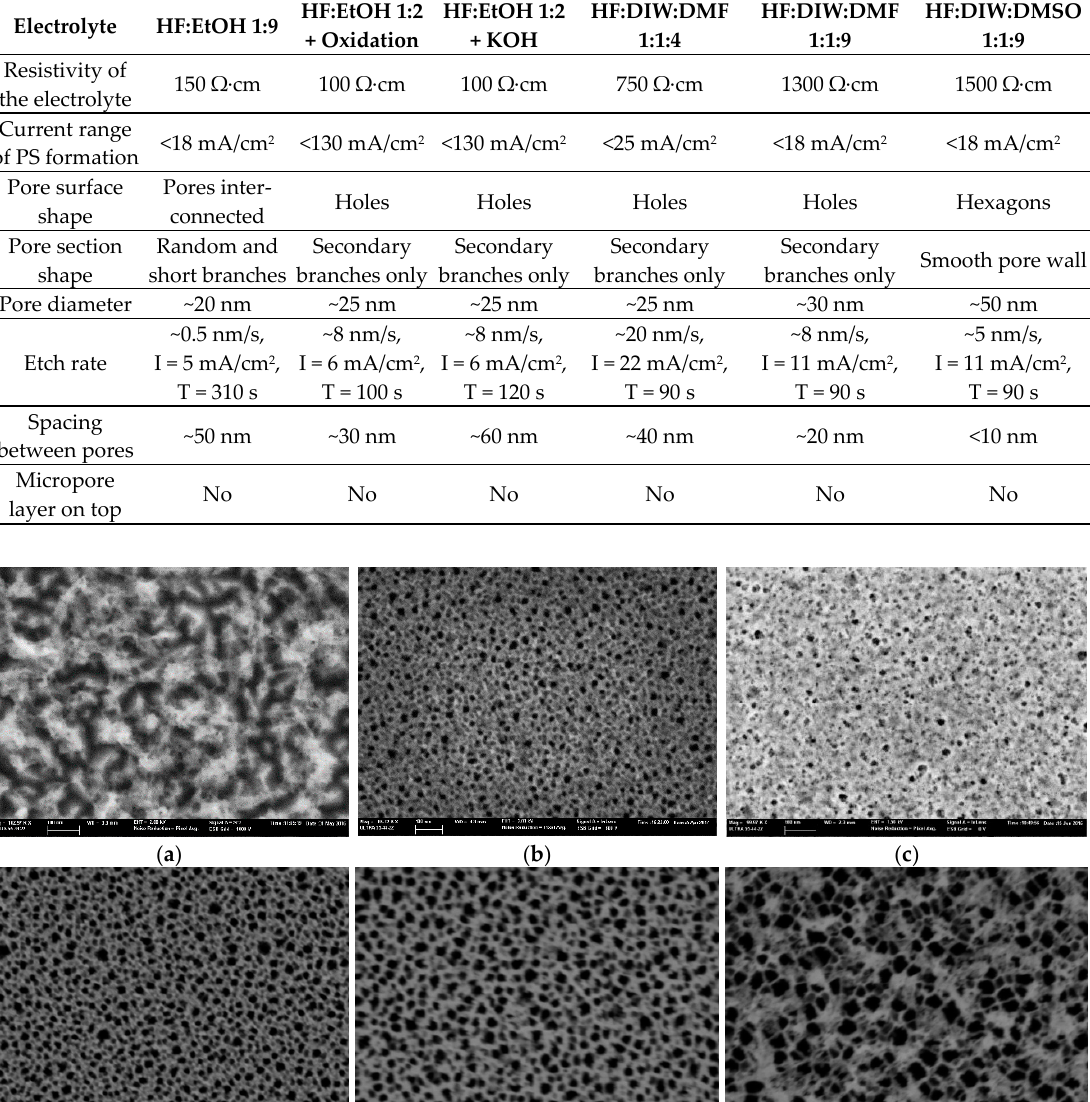
Table 1. Influence on pore morphology of fabrication parameters for a resistivity of 0.01–0.02 Ω∙ cm.